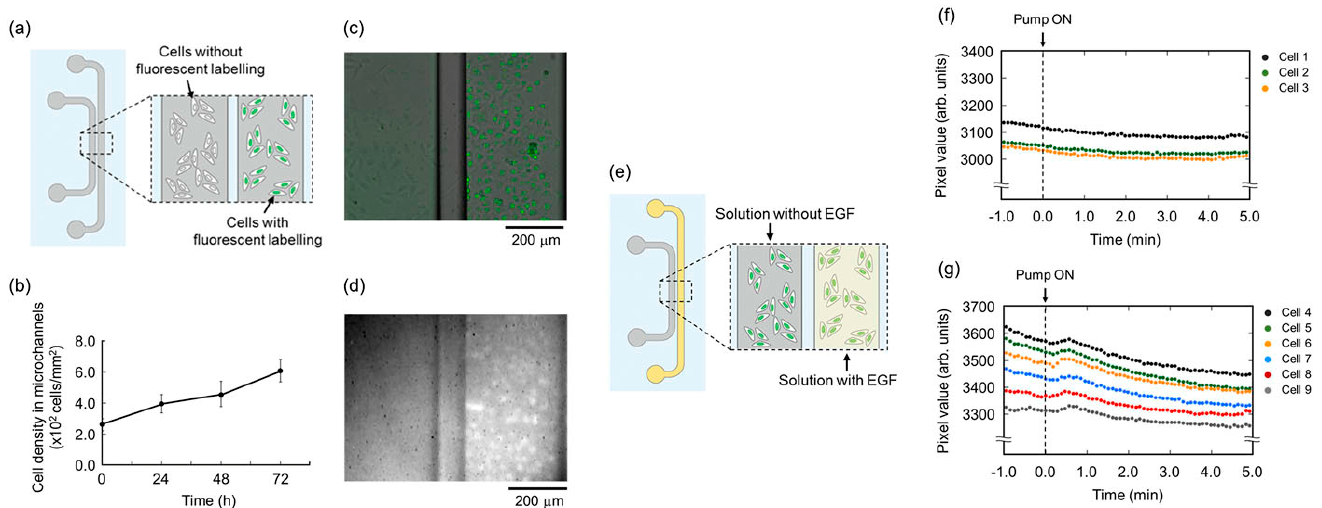
Figure 14. Panel ( a ) represents the cells in the microfluidic channels and panel ( b ) represents the number of cells in the microchannels as a function of time. Demonstration of lens-free on chip fluorescence imaging HeLa cells seeded on collagen treated microchannels, panels ( c , d ). Panel ( e ) is a schematic of EGF delivered to the microchannels, panel ( f , g ) are the time course to detected fluorescence of the cells being imaged. Reproduced from [122] under Creative Commons Attribution 4.0 License.